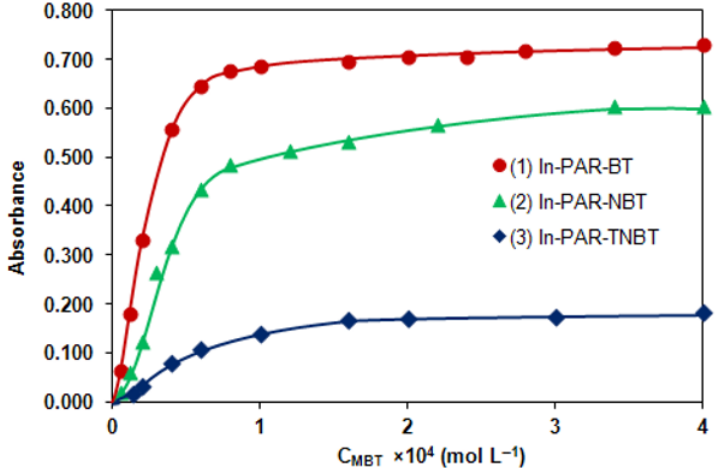
Figure 3. Absorbance of the extracted ternary In(III)-PAR-MBT complexes vs . concentration of the PAR plots. C 4.0×10 −4 mol L −1 , λ =515 nm, pH=8.5 (curves 1 and 2) or 8.3 (curve 3).